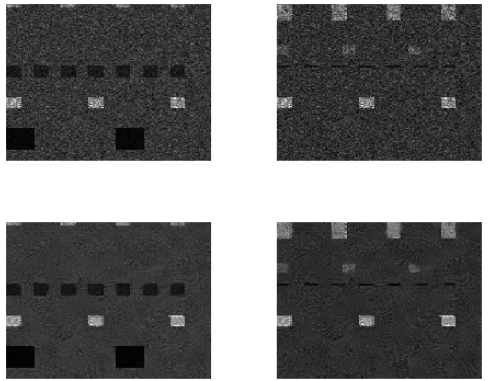
Figure 3. Examples of simulated images filtered by the proposed Spatio-Temporal NL-means filter.